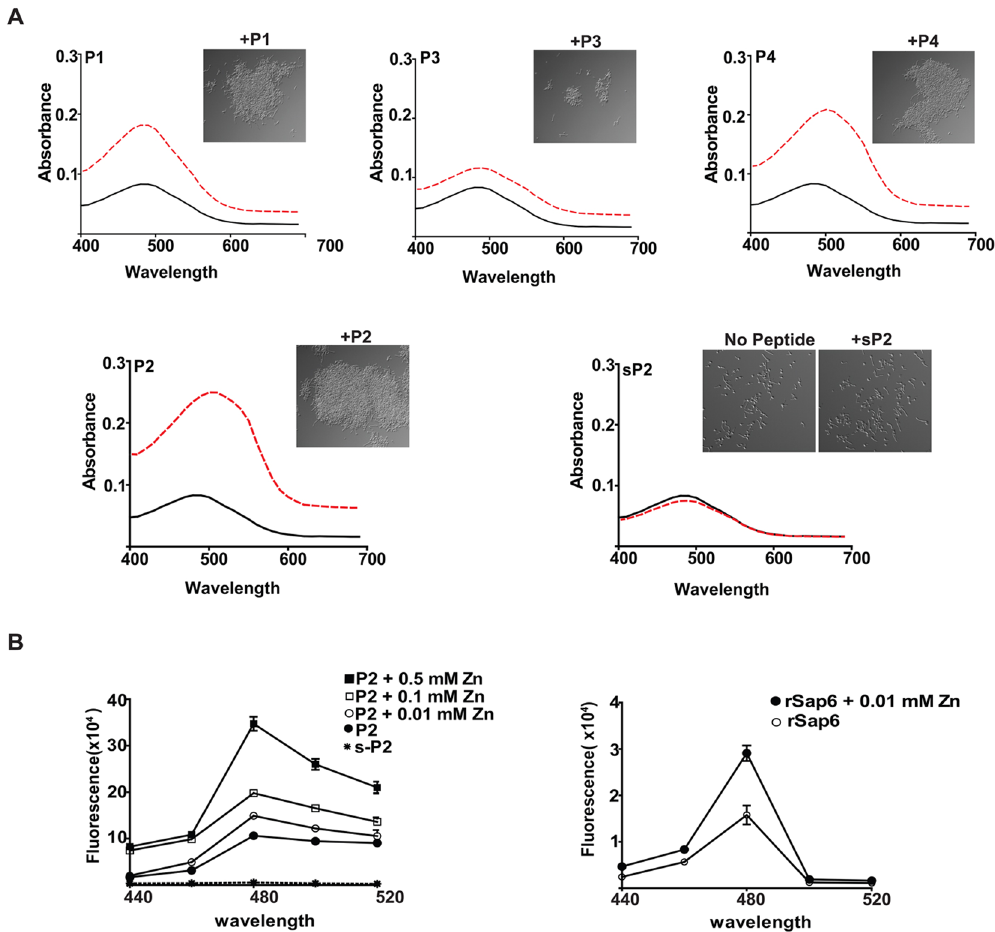
Figure 3. Sap6 amyloid regions induce fungal cell aggregation proportionally with the degree of amyloid structure shown by Congo red binding, and zinc further increases amyloid structure. ( A ) Amyloid structure of peptides P1–P4 and a scrambled P2 peptide (sP2) was evaluated by their affinity for Congo red that specifically binds to amyloid structures. Absorbance spectra (400–700 nm) of Congo red alone (solid black lines) or with peptides P1–P4 (dashed red lines) were measured. Autoaggregation of germinated C . albicans was observed microscopically following 15 min incubation with each peptide. Cell aggregation was the largest for P2, with moderate autoaggregation with P4 and P1, while P3 induced very little aggregation. Amyloid structure (as shown by amount of Condo red absorbance) was largest for P2, followed by P1 and P4, while P3 showed the least absorbance. The scrambled peptide sP2 did not form aggregates nor show Congo red absorbance. ( B ) Thioflavin T (ThT) binding with amyloid structures was measured (440 nm–520 nm) with peptide P2 and sP2 (10 µ M) (left panel) or rSap6 (right panel) following pre-incubation with ZnCl 2 (0–0.5 mM) for 4 h. ThT fluorescence was maximal at 480 nm (showing the presence of amyloid structure) for both P2 and full length rSap6, but the scrambled P2 peptide had no evidence of amyloid structure as shown by the lack of ThT absorbance. Addition of zinc to both P2 and rSap6 increased amyloid structure as shown by the increased fluorescence. Data are the mean ± SD for three independent